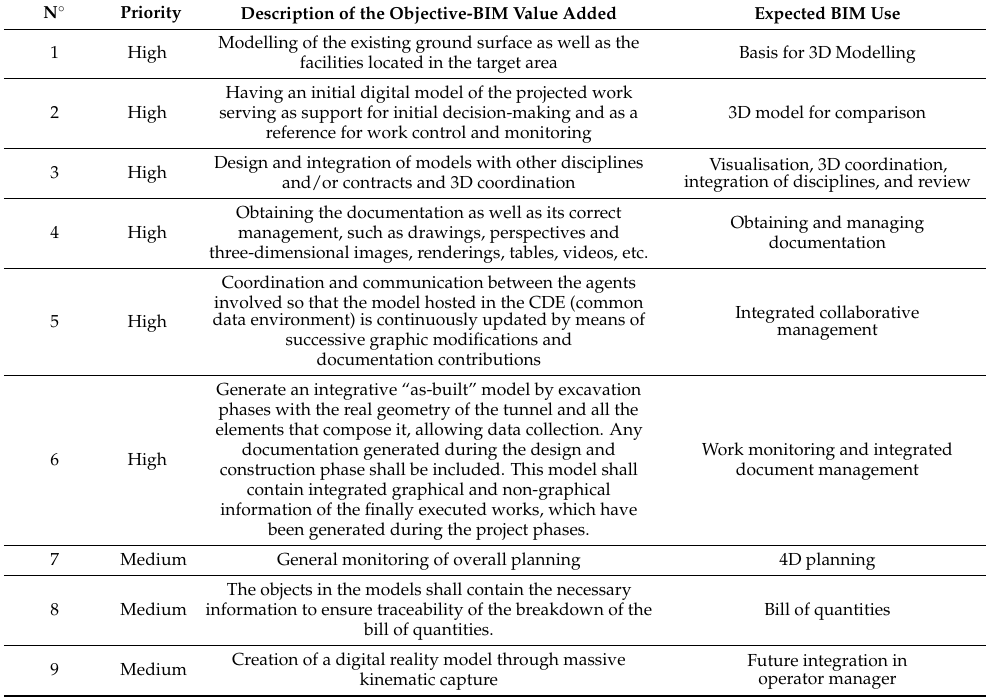
Figure 7. Critical areas in the initial model for interference detection. In the second phase, the updated BIM model was developed (Figure 8), whose main uses consisted of coordinating the 3D design, not only between disciplines, but also with the rest of the project lots, 4D planning, and being the reference base for the construction process by including the resolution of each of the discrepancies identified in the initial model. However, one of the most relevant uses of this model and the common data environ ‐ ment arose from the need to use the most up ‐ to ‐ date information possible for the design of the project for the execution of the facilities. Permission was granted to the successful bidders of this contract to access the model and the most up ‐ to ‐ date information neces ‐ sary, thus minimizing possible future discrepancies and therefore contributing efficiency and great value to the concept of “collaboration” for which the BIM methodology is char ‐ acterized.